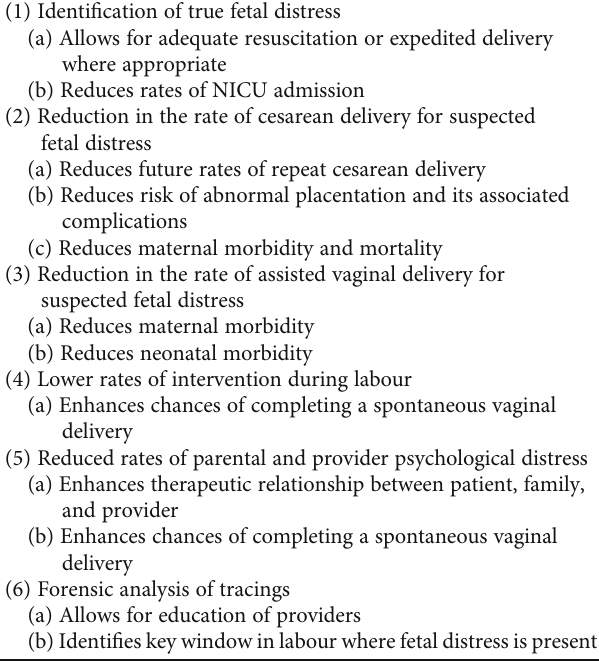
Table 1: Summary overview of the implications of a successful FETAL